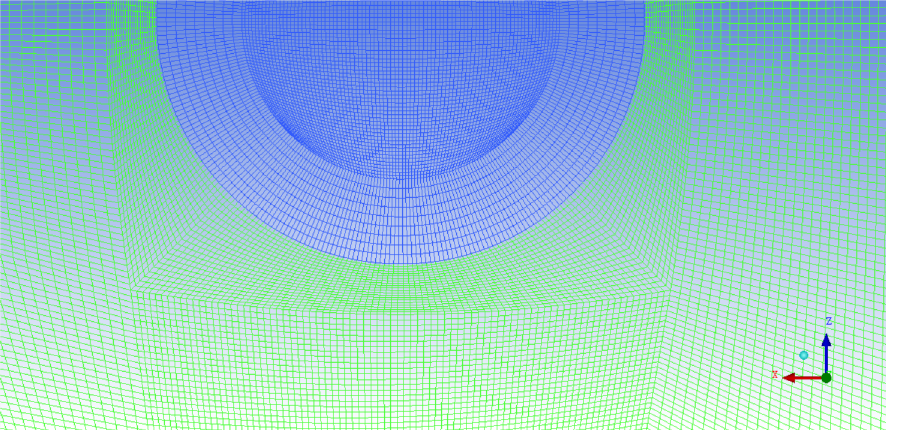
Figure 3. Meshing